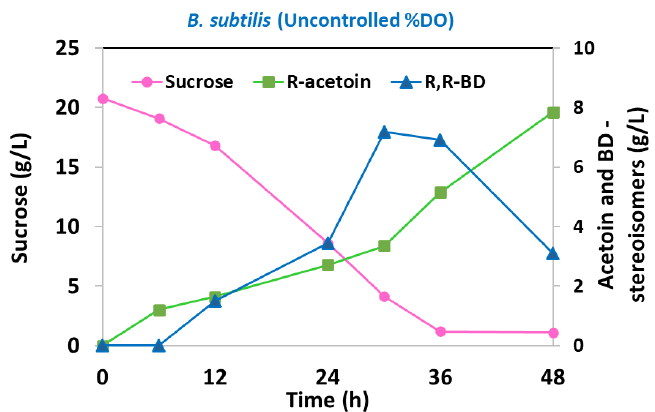
Figure 3. Time courses of acetoin and 2,3-BD isomers produced by B. subtilis from sucrose-based medium in 2 L bioreactor with uncontrolled DO at 30 ◦ C, pH 6, aeration rate 1.0 vvm.